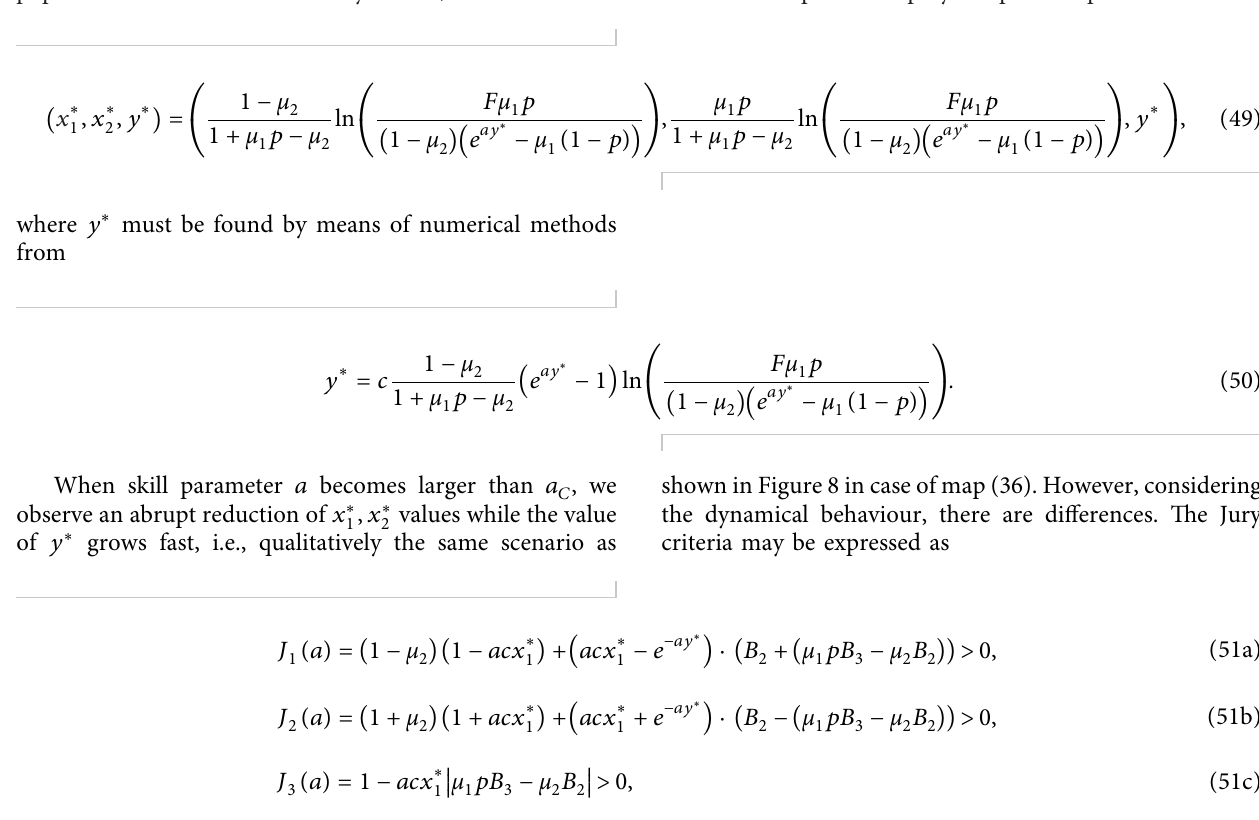
Figure 11: (a) Values of x ∗ , x ∗ and y ∗ as functions of skill parameter a , map (37). (b) Jury criteria, J 1 2 , μ ,p, F,c ) � ( 1 , 0 . 1 , 0 . 8 , 5 , 0 . 5 ) values ( μ 1 2